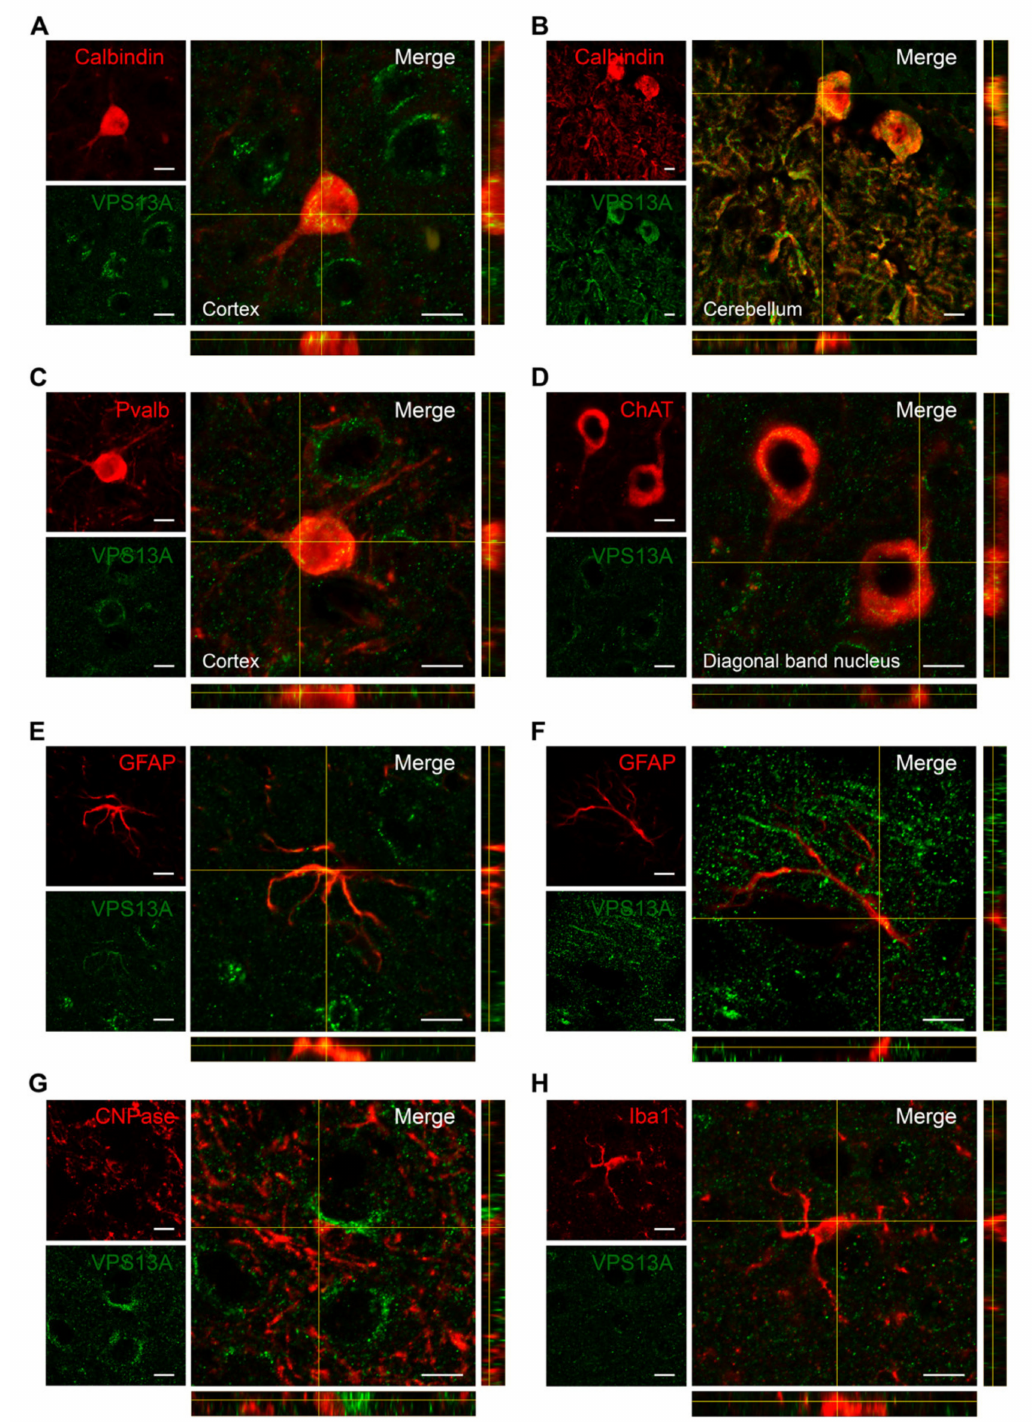
Figure 5. VPS13A is present in GABAergic, cholinergic neurons, and a few astrocytes, as well as to a lesser extend in oligoden- drocytes or microglia. Orthogonal view from different planes of representative confocal images of ( A , B ) VPS13A/Calbindin- positive GABAergic neuron, ( C ) VPS13A/Parvalbumin-positive GABAergic neuron, ( D ) VPS13A/ChAT-positive cholinergic neurons, ( E , F ) VPS13A/GFAP-positive astrocytes, ( G ) VPS13A/CNPase-positive oligodendrocytes, and ( H ) VPS13A/Iba1- positive microglia in sagittal sections of the mouse brain. n = 3. Scale bar 10 µ